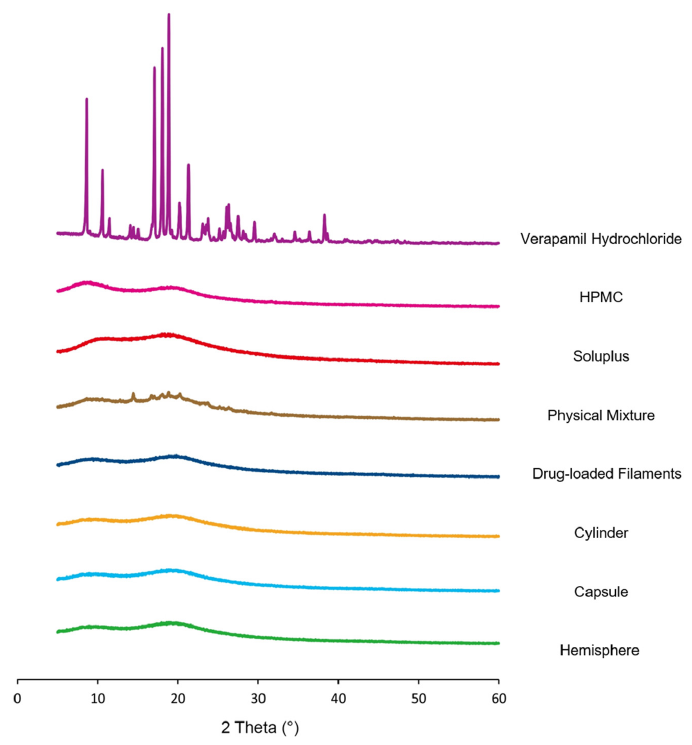
Figure 6. XRD results of verapamil hydrochloride, HPMC, Soluplus, physical mixture, drug-loaded filaments and formulations.